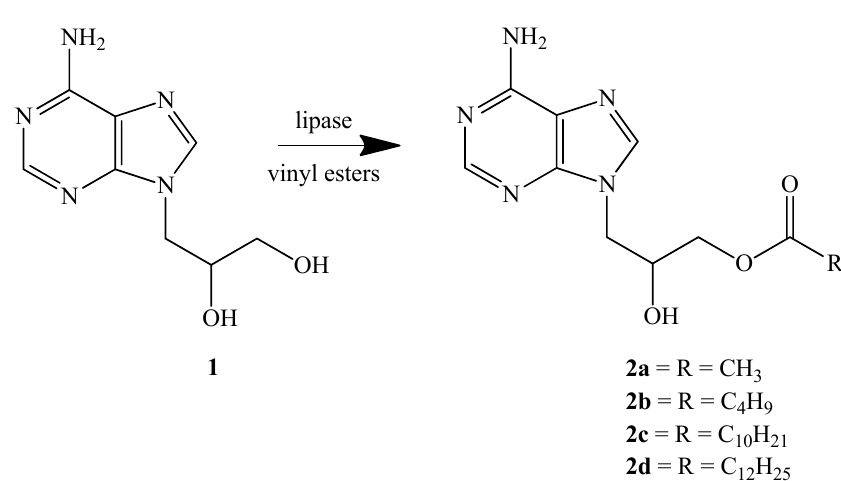
(free form) and Geotrichum candidum 4013 (cell-bound lipase as the acetone powder, immobilized cell-bound lipase and immobilized extracellular lipase) were used for preparative scale purposes. Scheme 1. Reaction